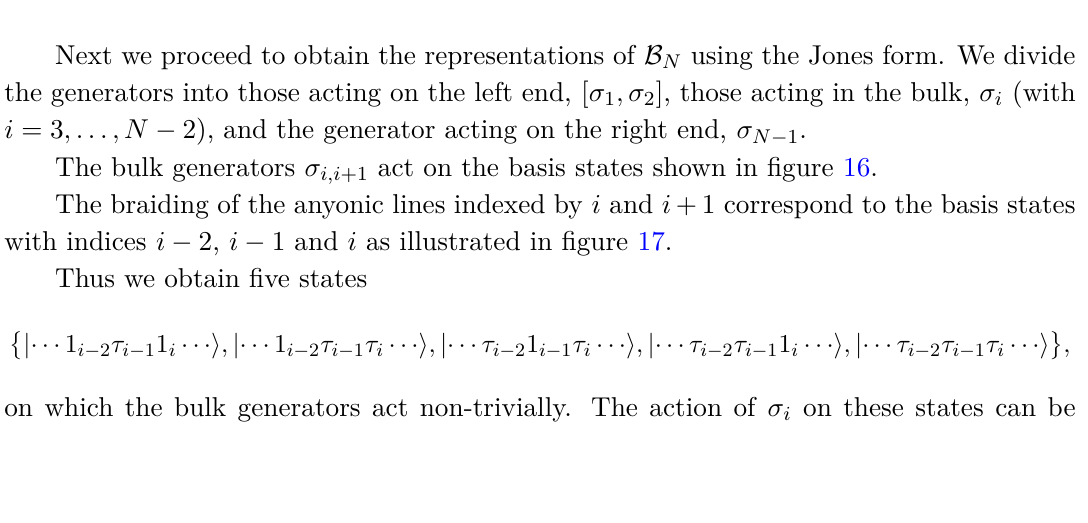
Figure 16 . The basis vectors in the bulk on which σ i has a non-trivial